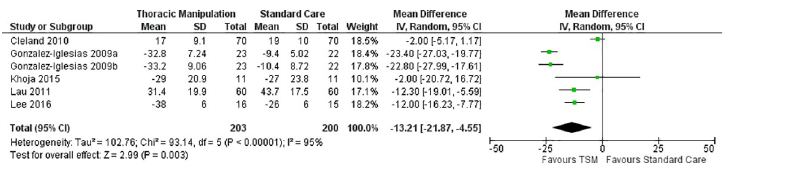
Fig 4. Meta-analysis of TSM versus standard care for pain at short-term follow-up.